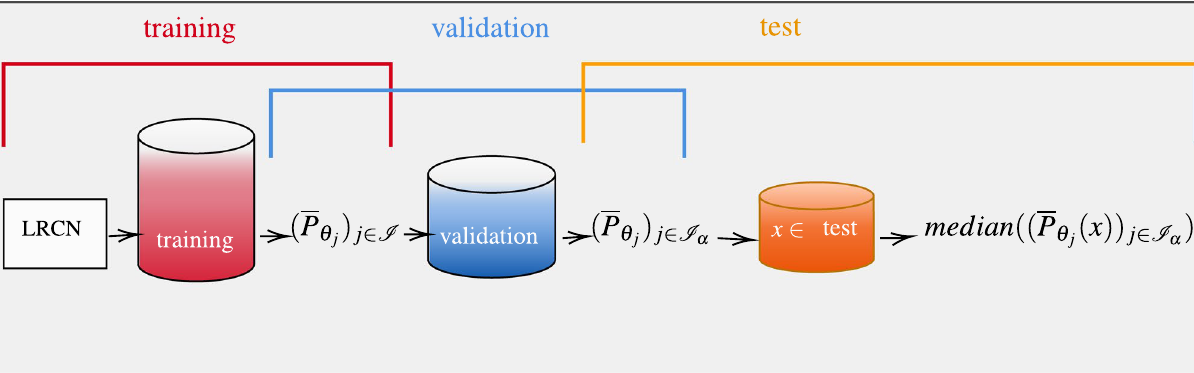
Figure 4. Pipeline diagram for the ensemble method. The first step consists in training the LRCN model (the architecture is shown in Fig. 2) over a fixed number of epochs and computing the classification thresholds defined in (10): the outputs of the training process are the estimators ( P θ of epoch indexes. The second step consists in validating the estimators ( P θ provide predictions on the validation set with scores over a level α , which is determined through the procedure described in Eqs. (14)–(17). The final step consists in testing the method on a new input: the prediction of the ensemble method is given by computing the median of the estimators ( P θ